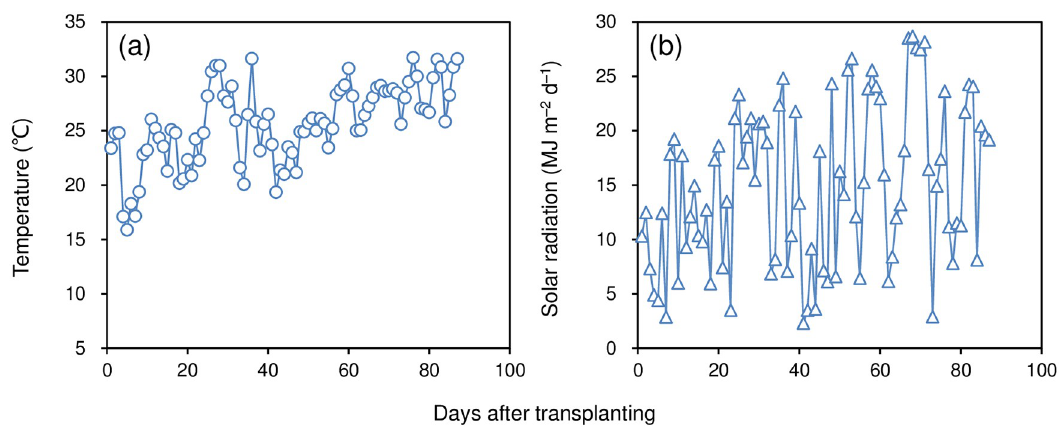
Fig 1. Daily mean temperature (a) and solar radiation (b) in the early rice-growing season in